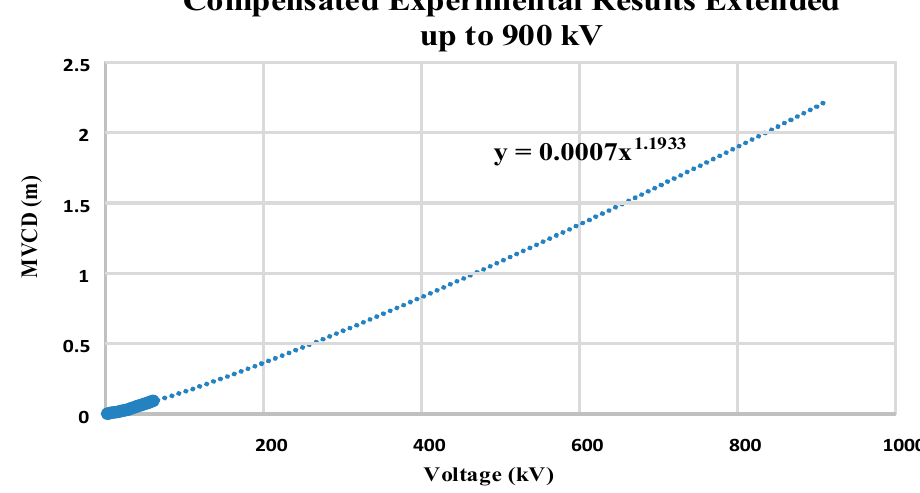
Figure 7. Compensated Experimental Results Extended up to 900 kV.